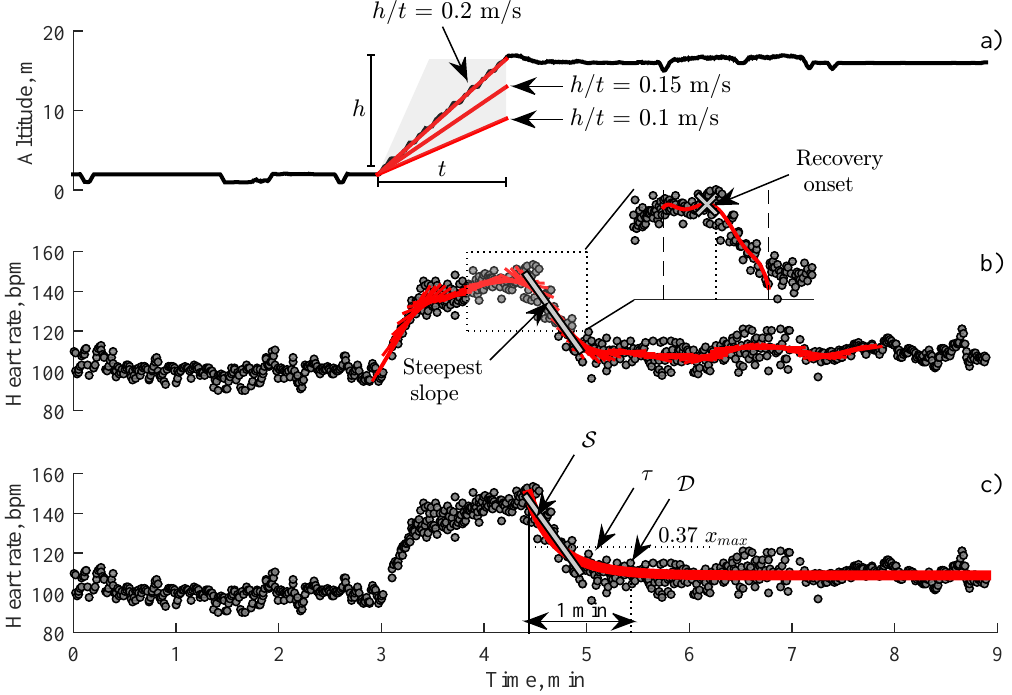
Figure 3. Estimation of heart rate recovery (HRR) parameters in heart rate series with a stair climbing activity: ( a ) altitude with the onset of stair climbing at 3 min, ( b ) detection of the steepest falling slope in a synchronously recorded heart rate series where the peak in the fitted polynomial corresponds to the recovery onset, ( c ) estimation of HRR